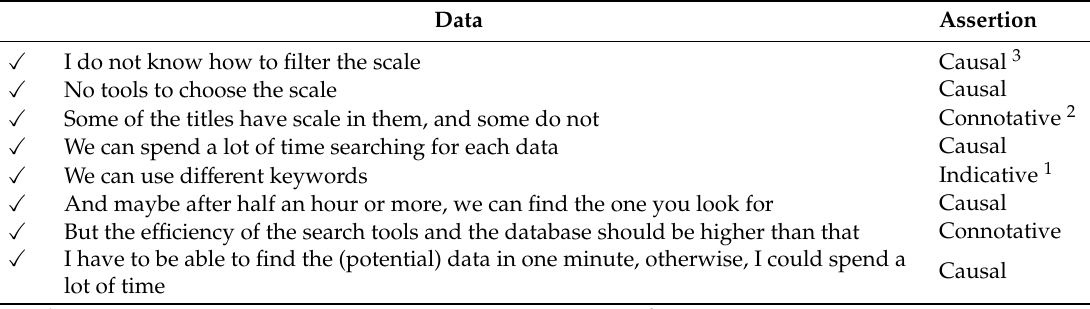
Table 3. Example of assertions analysis of the TAP data.